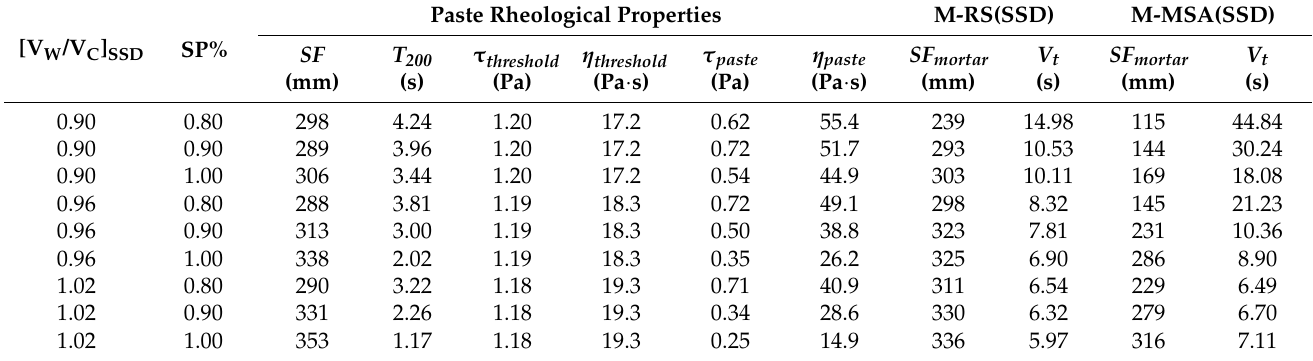
Table 3. Experimental results of pastes and